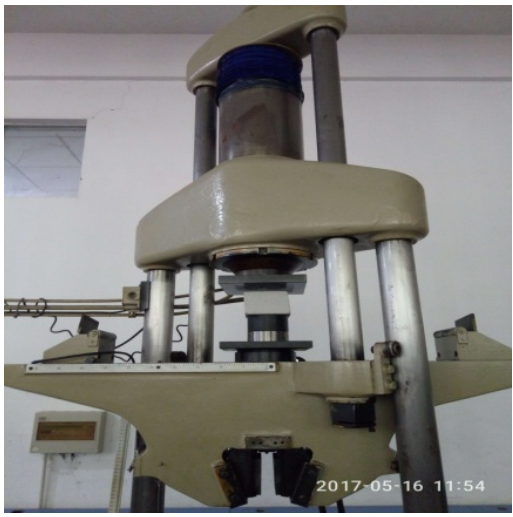
Figure 3. Material testing machine.